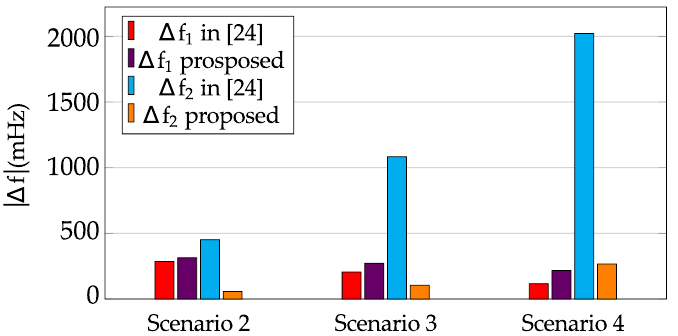
Figure 18. Comparison between ∆ f 1 and ∆ f 2 for the different scenarios depending on the wind power plant control and considering ∆ P L =